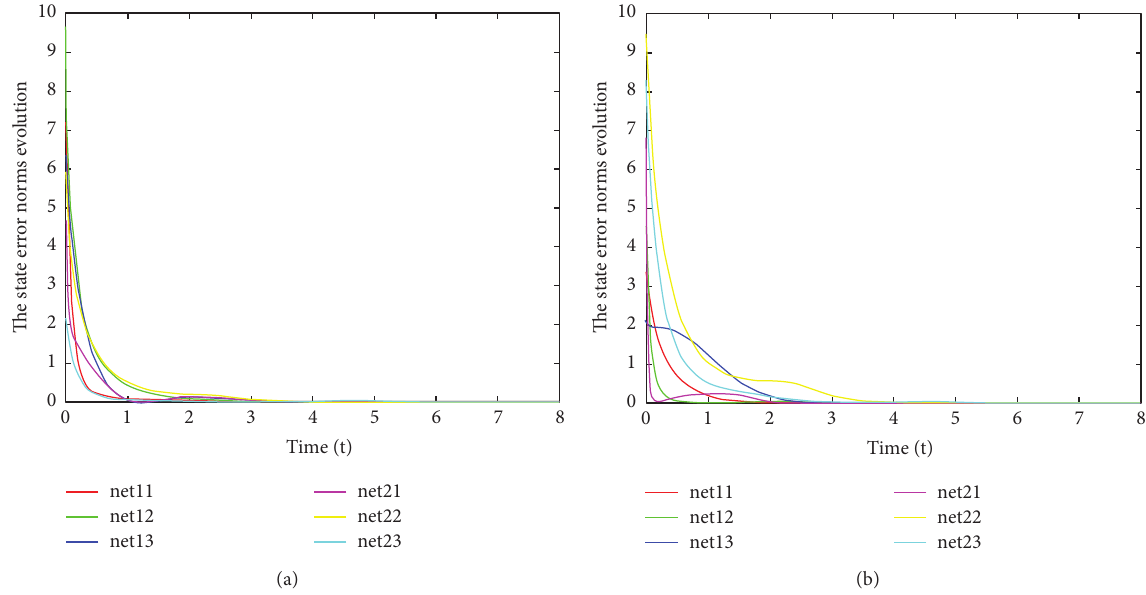
Figure 6: Real part and imaginary part of state error evolution under the piecewise event-triggered control. (a) Real part of state error evolution. (b) Imaginary part of state error evolution.